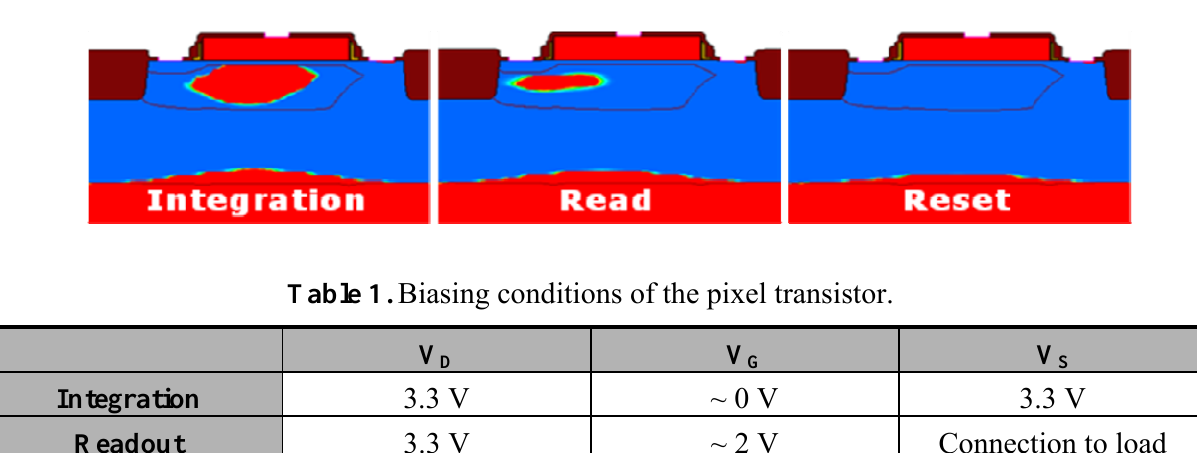
Figure 2. Simulations of the 1T pixel using ISE TCAD tools to verify its operation in different phases.